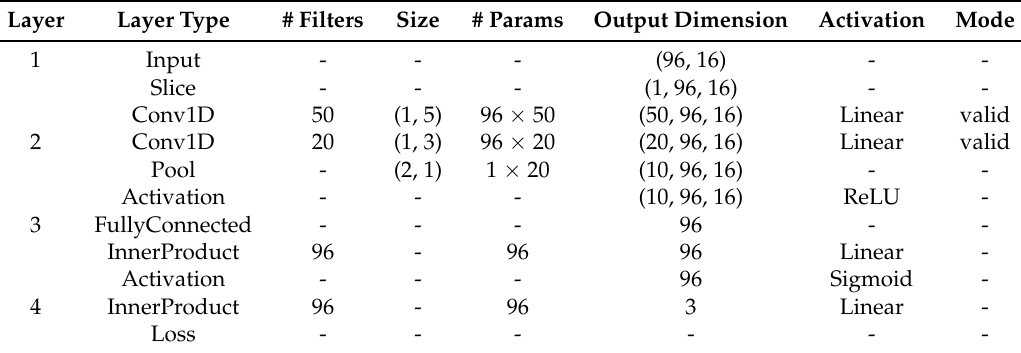
Figure 3. Multi-channel CNN architecture (CNN96). Architectural details are presented in Table 1. Table 1. CNN96 architecture